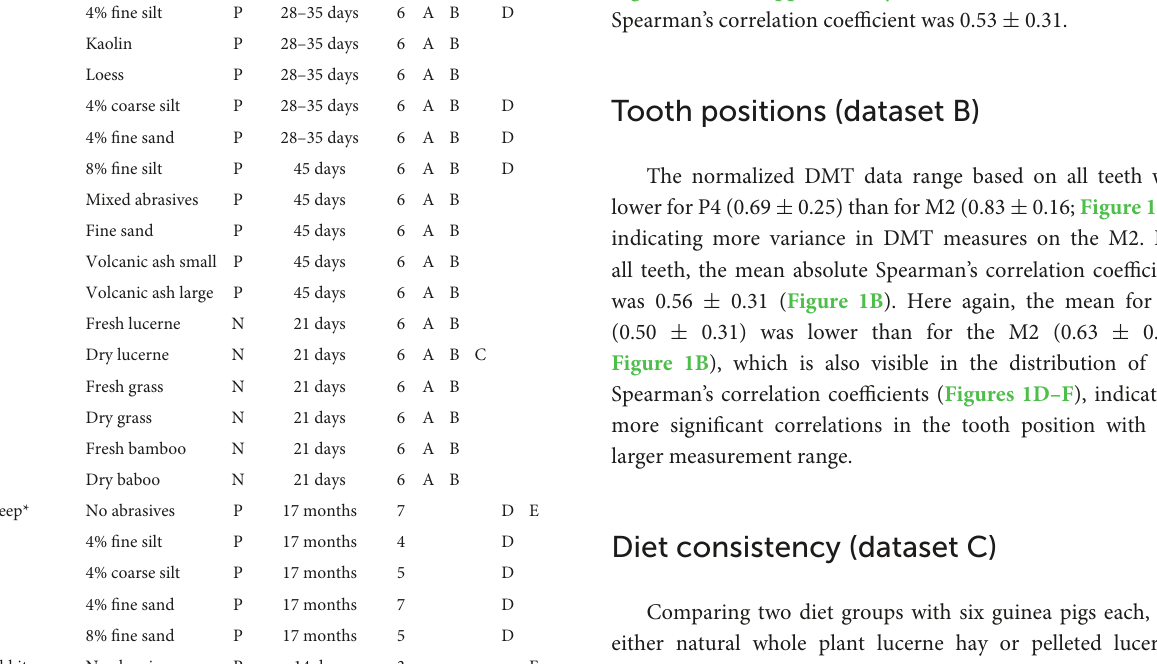
correlated positively (or, in fewer cases, negatively) with each other. The direction, density, and complexity parameters show the “lighter areas” of the triangular diagram ( Supplementary Figure 1 and Supplementary Table 3 ). The mean absolute Spearman’s correlation coefficient was 0.53 ±